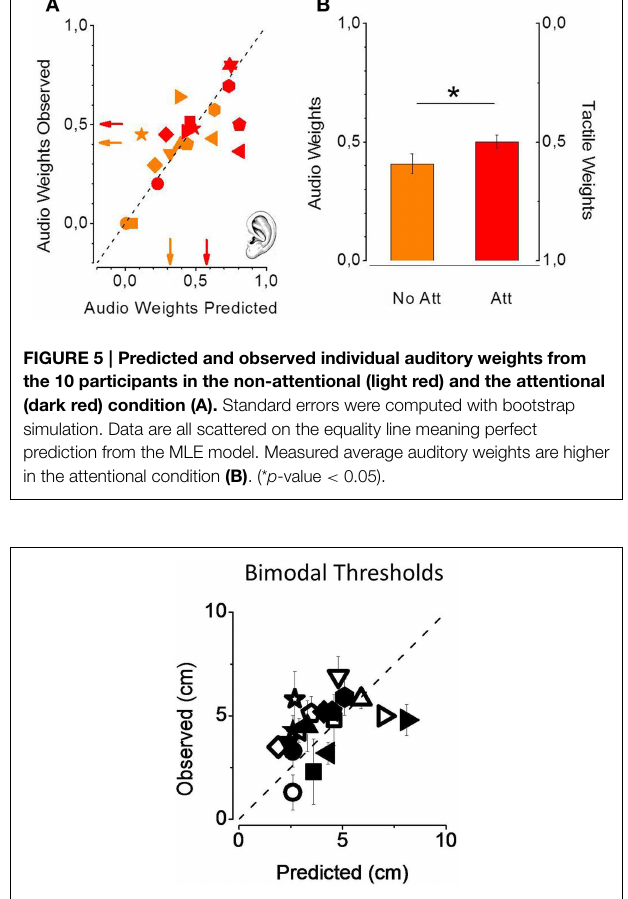
FIGURE 6 | Predicted and observed individual thresholds (A) for both the non-attentional (empty symbols) and the attentional condition (filled symbols). Standard errors were computed with bootstrap simulation. Data are well-predicted by the MLE